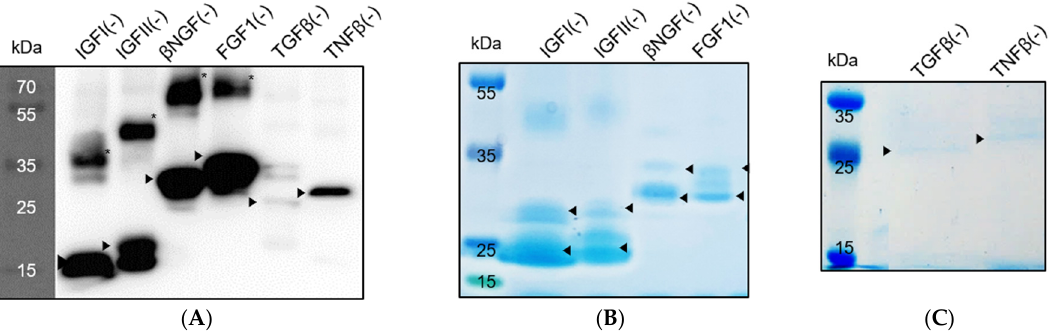
Figure 5. Recombinant growth factor secretion analysis of P . fluorescens Δ fleQ in flask. ( A ) Western blotting of the purified His-tagged protein from the culture supernatant. ( B , C ) SDS-PAGE analysis of the purified His-tagged protein from the culture supernatant. ► , monomer protein; *, dimer protein. The bands which appear in pairs ( ◄ ), most visible in ( B ), are the protein’s oxidized and reduced forms of proteins.